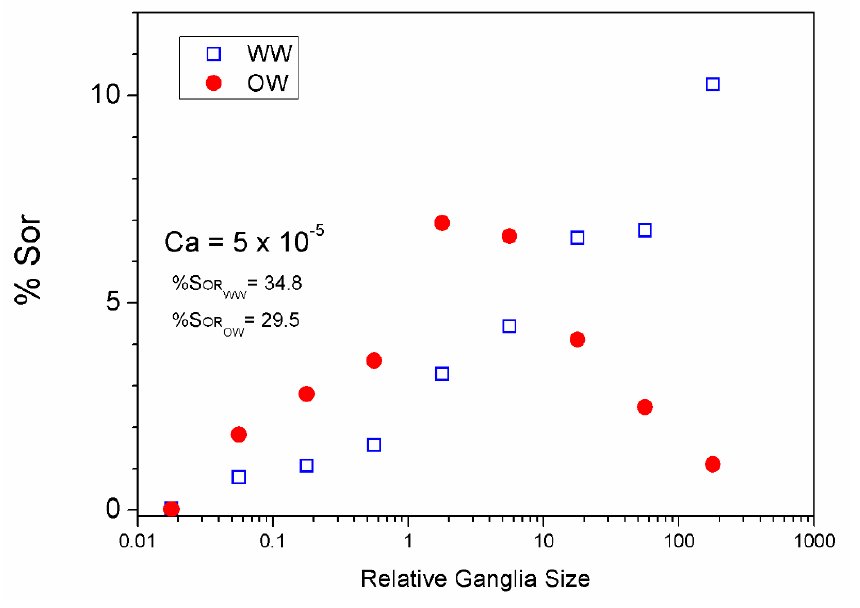
Figure 13. Distribution of the trapped oil as a function of ganglia size for both WW and OW pore network models.